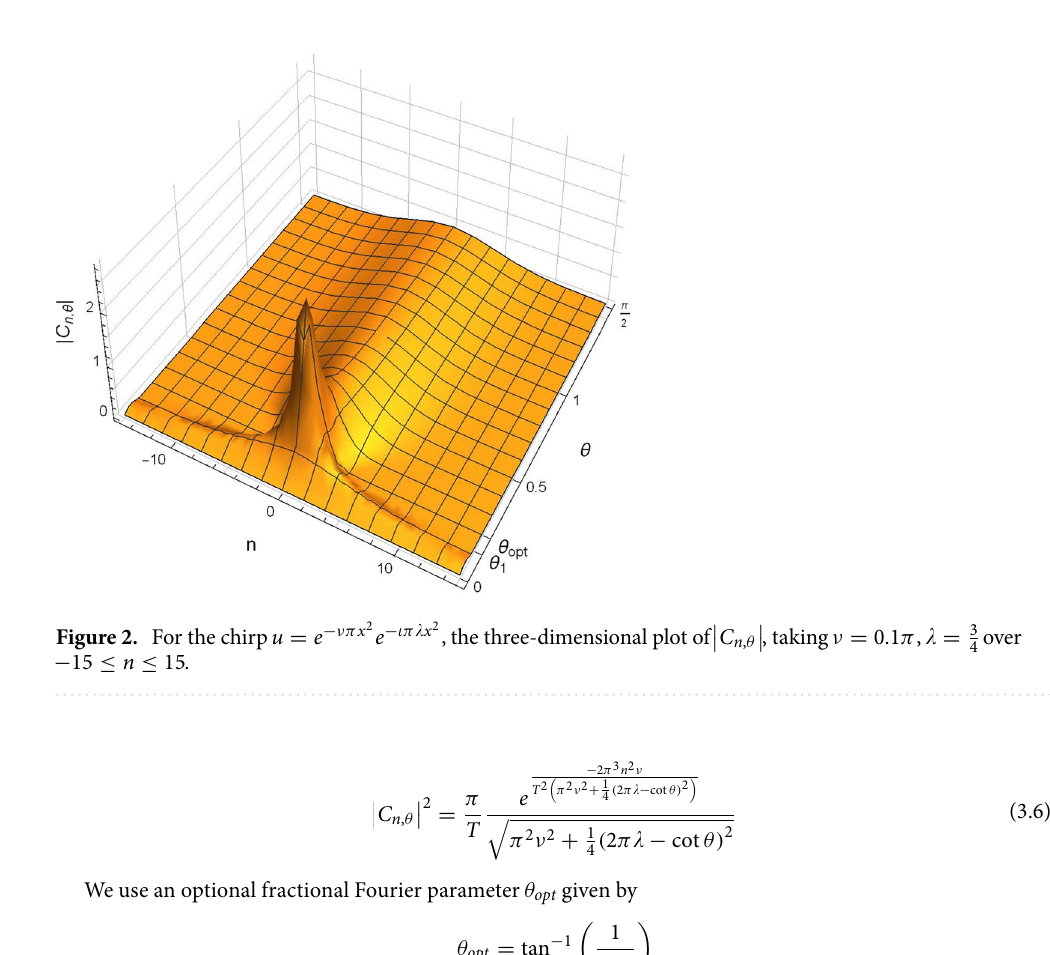
C n , θ using (cid:31) (cid:31) (cid:31) (cid:31) (cid:31)